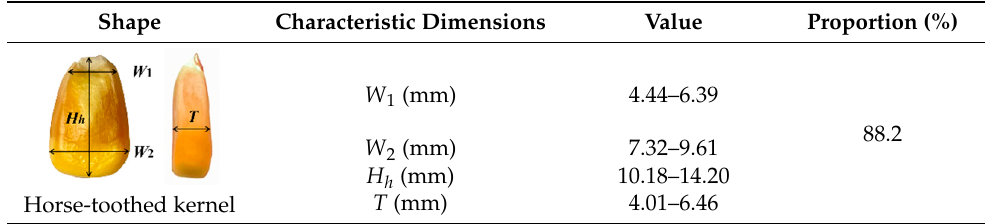
Table 4. Shapes and characteristic dimensions of corn kernels in three shapes. Shape Characteristic Dimensions Value